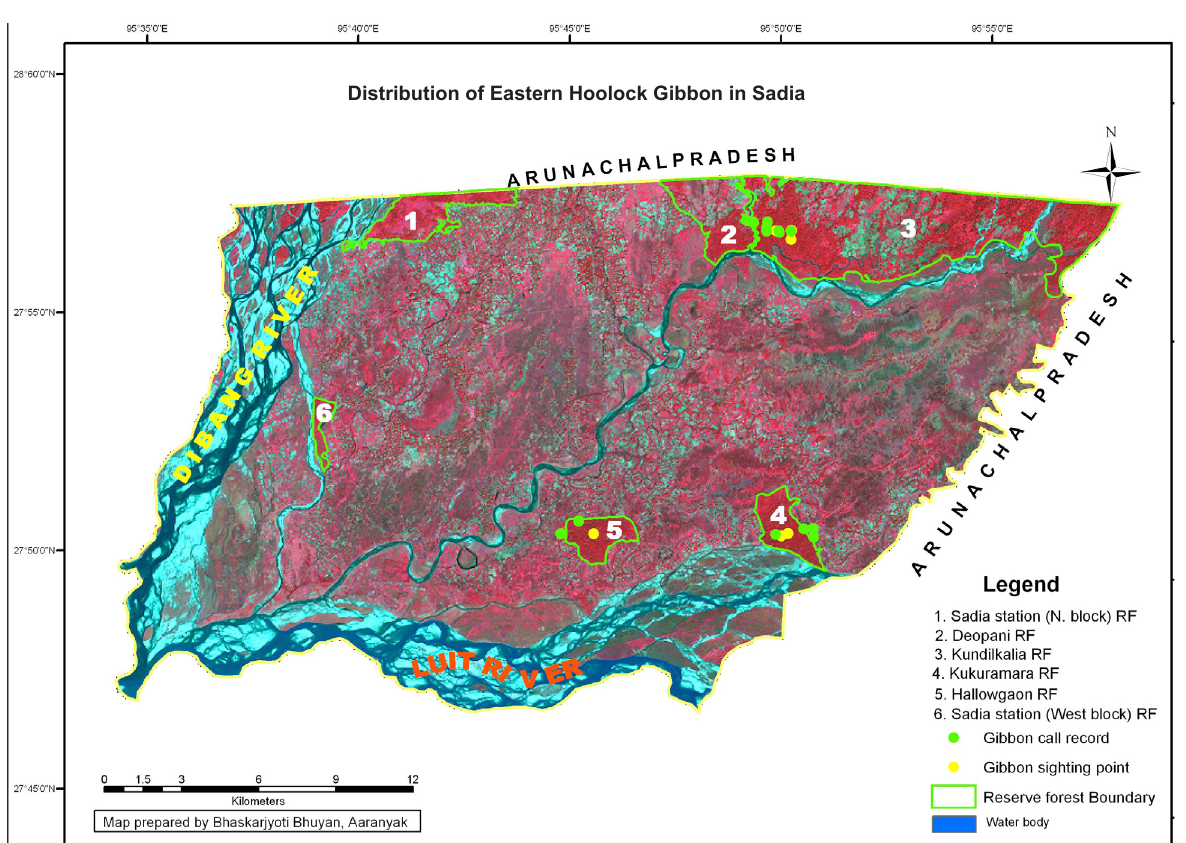
Image 3. Distribution of Eastern Hoolock Gibbon in Sadiya